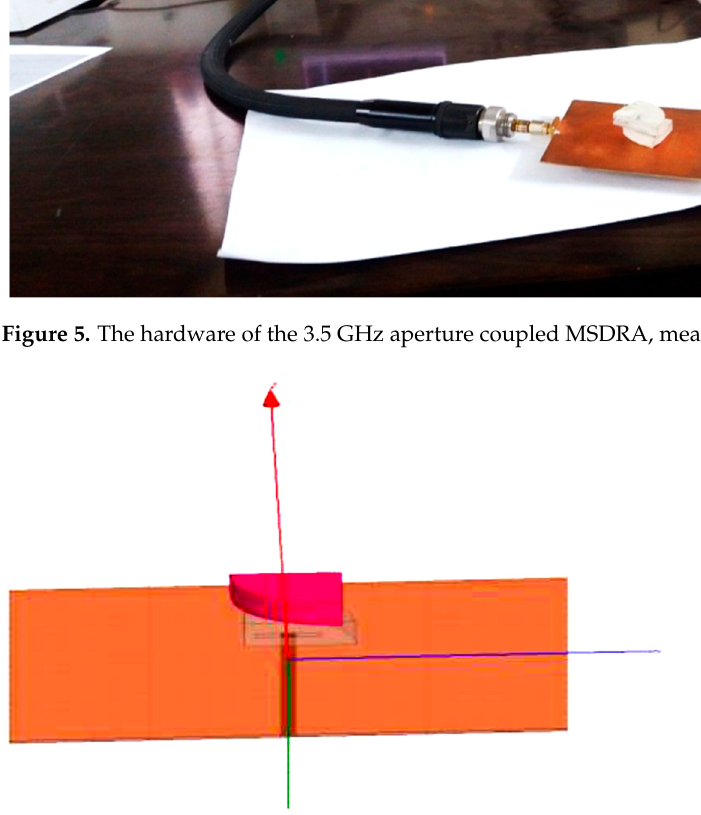
Figure 6. The proposed aperture coupled MSDRA hardware at 3.5 Giga-Hertz.